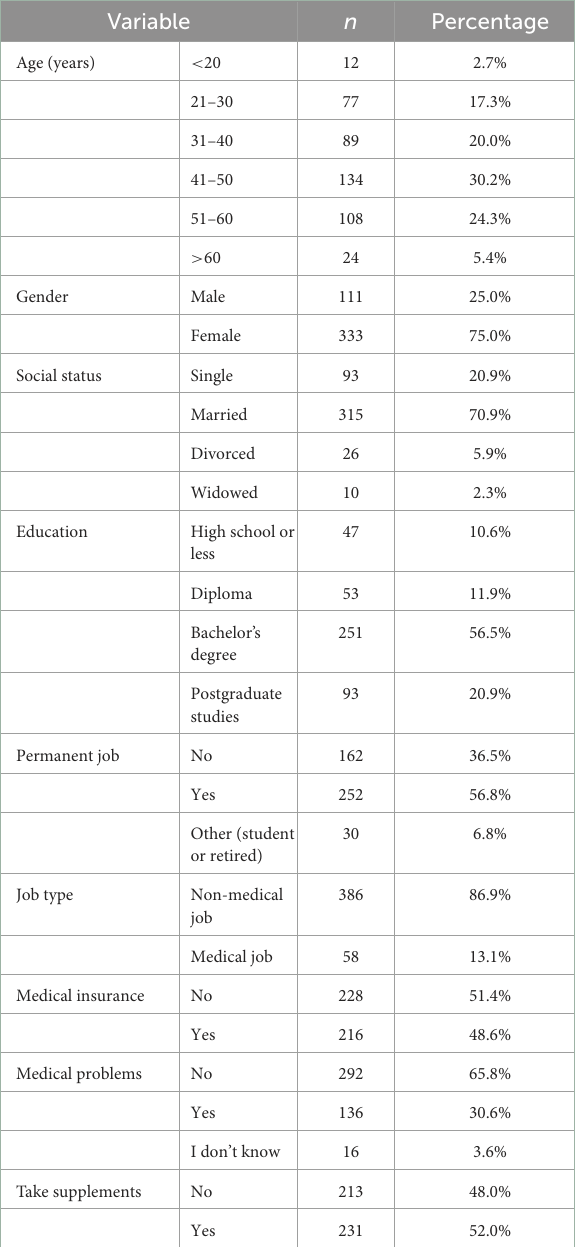
TABLE 1 Demographic characteristics of the study participants ( n =